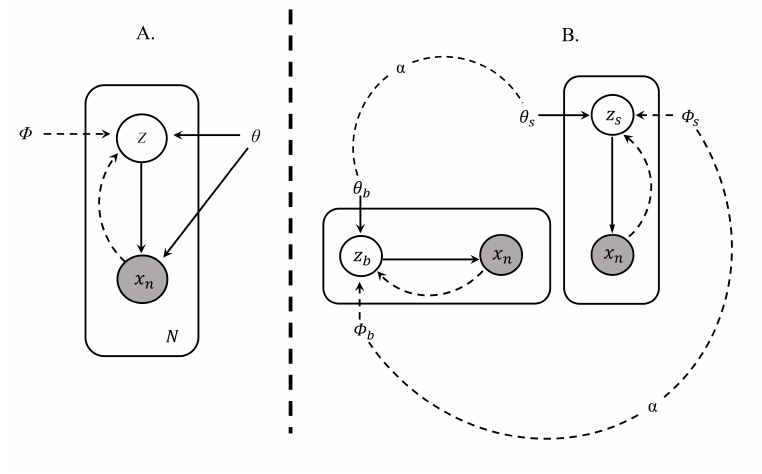
Figure 1. Variational autoencoder (VAE) vs. encapsulated VAE (EVAE). In this figure, we present the graphic model representations of ( A ) a VAE and ( B ) the derived EVAE. Solid arrows indicate decoders, whereas dotted arrows represent